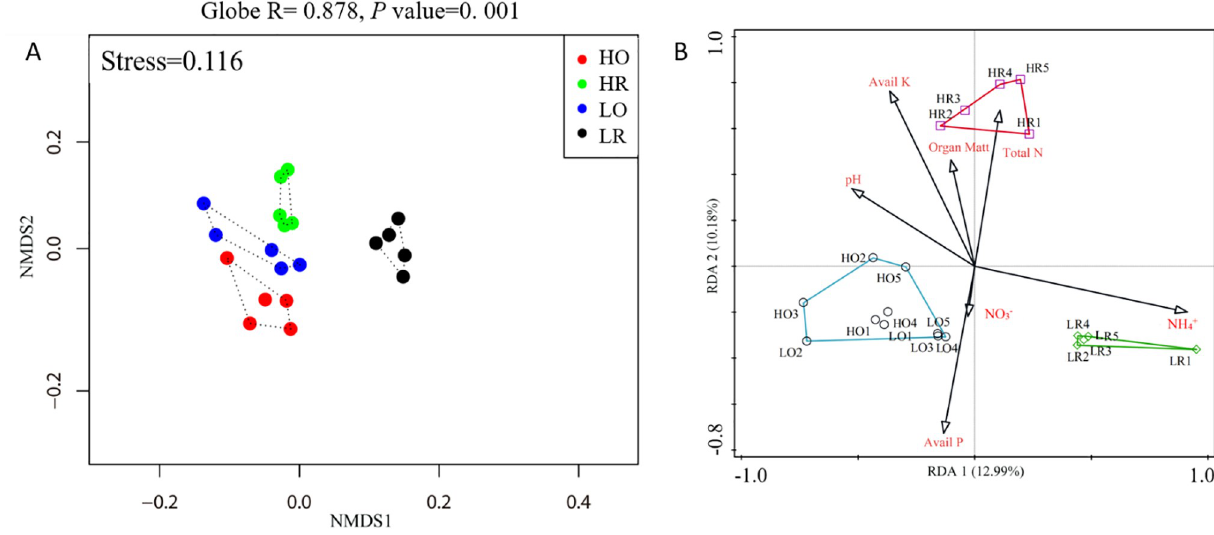
Fig 6. Nonmetric Multidimensional Scaling (NMDS) and Redundancy Analysis (RDA).